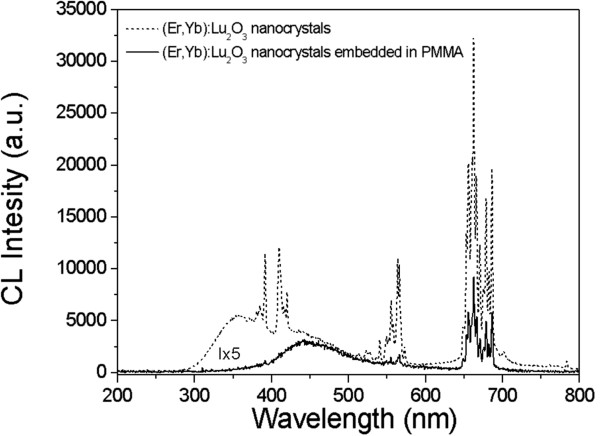
Cathodoluminescence spectra of (Er,Yb):Lu2O3 nanocrystals and (Er,Yb):Lu2O3 nanocrystals embedded into PMMA microcolumns.